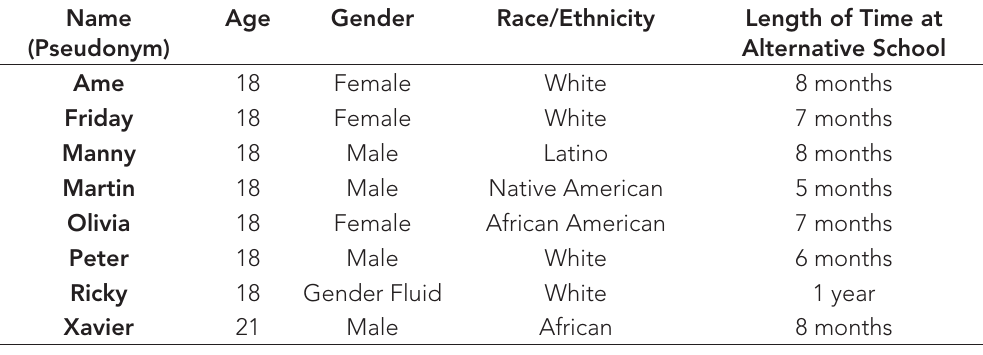
Table 5: Demographic characteristics of student participants (alternative high